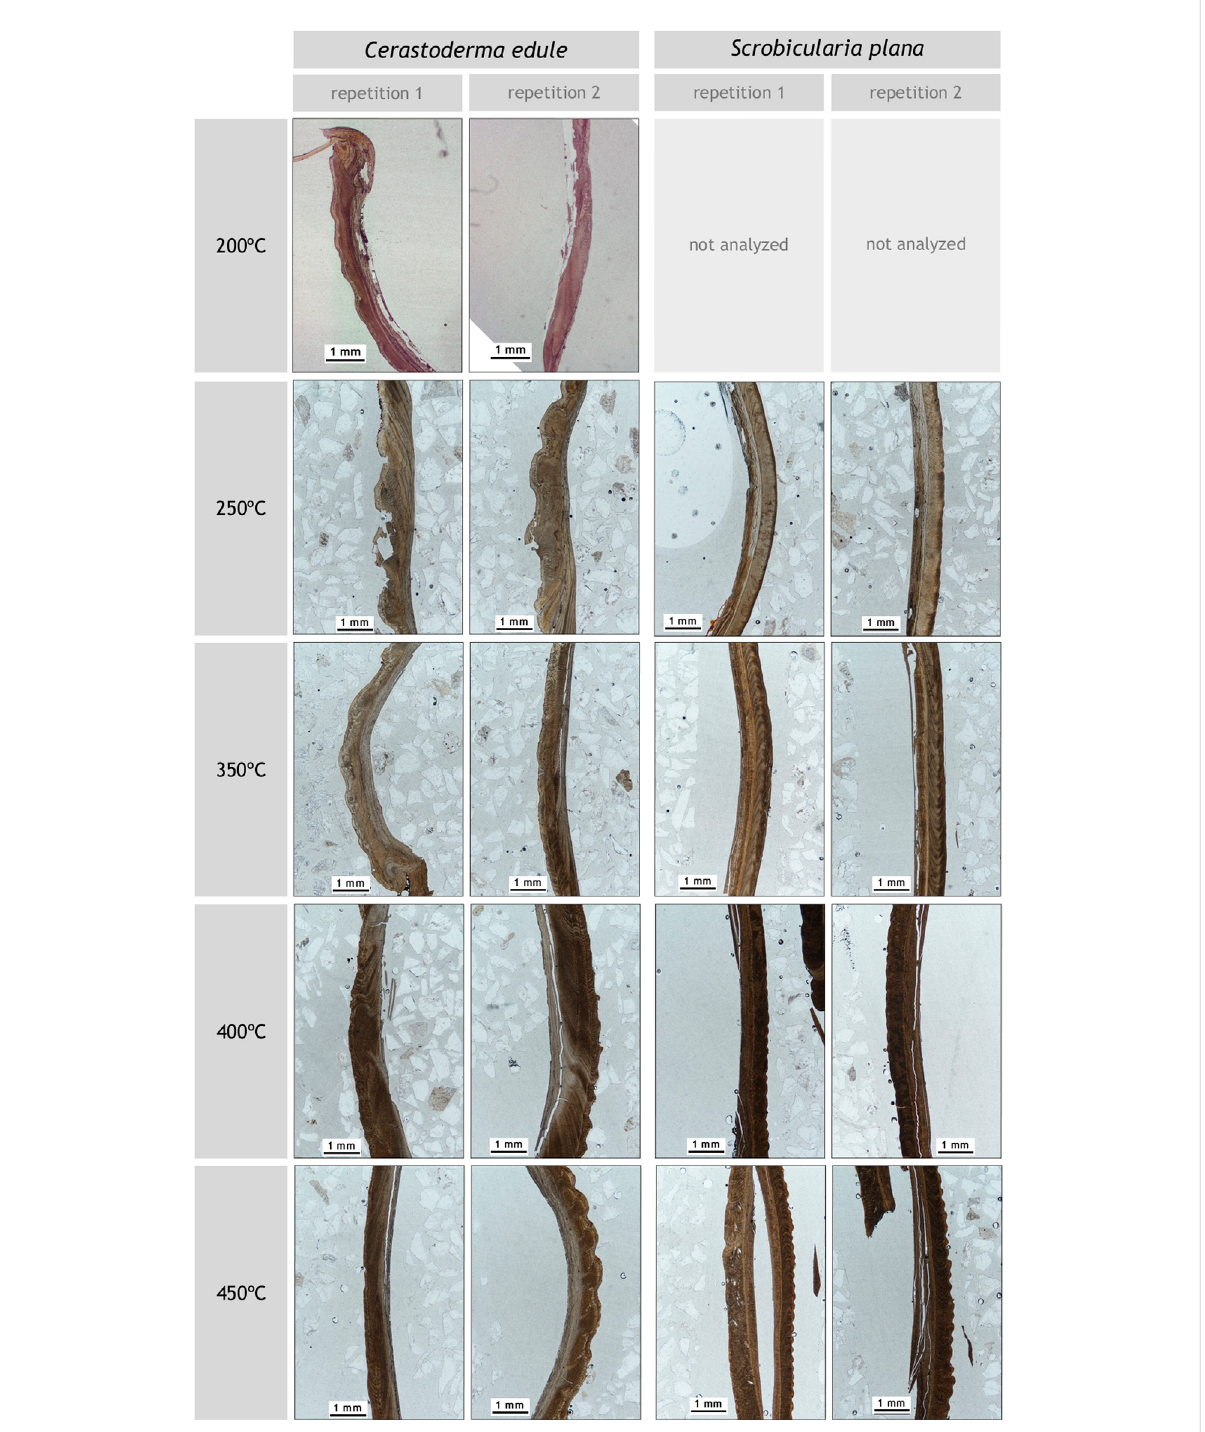
FIGURE 2 Petrographic images of the 18 thin experimentally heated shells used in this study, showing the observed effects of thermo-alteration: darkening and cracking increase with higher temperatures, though the crystalline structures are still